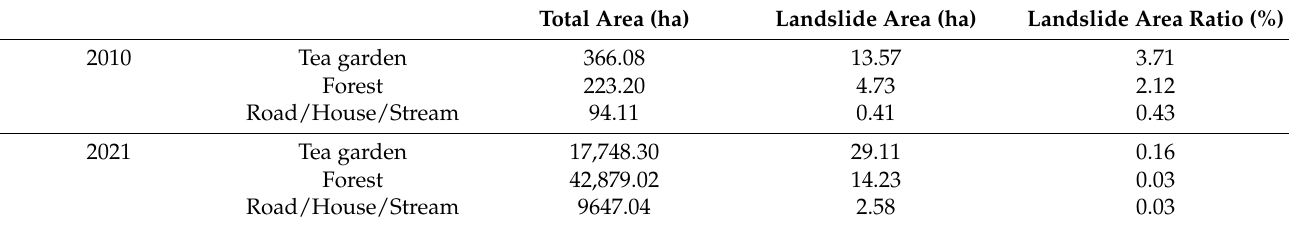
Table 5. Landslides in each land use area in 2010 and in 2021.